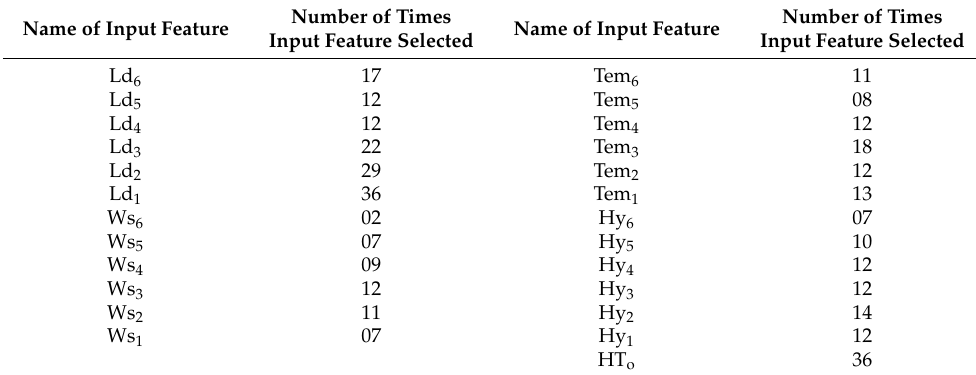
Table 3. Input feature selected (year-wise) for STLF.